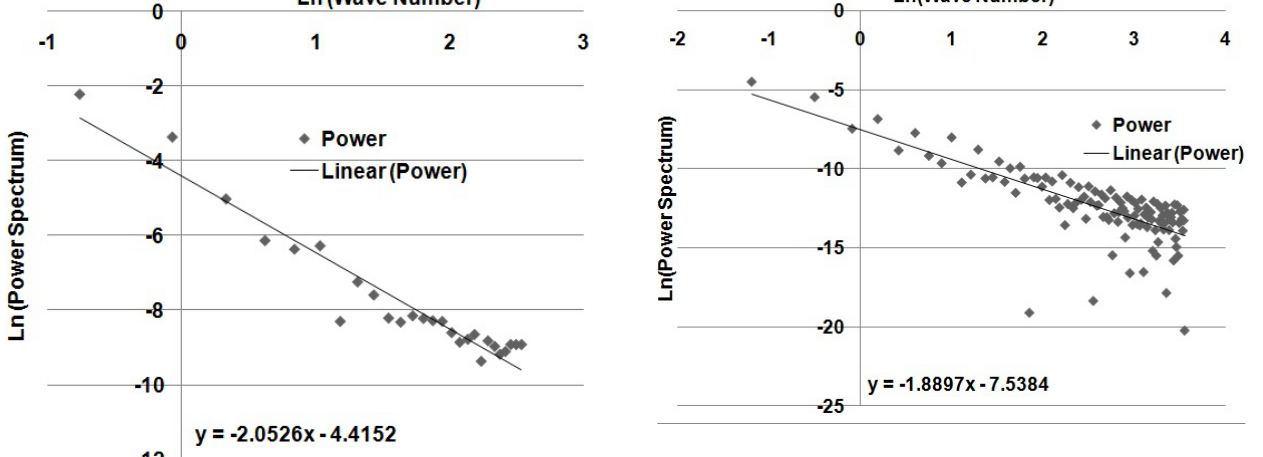
Table 2. Scaling exponents of the analyzed vertical heat production profiles. Area Scaling